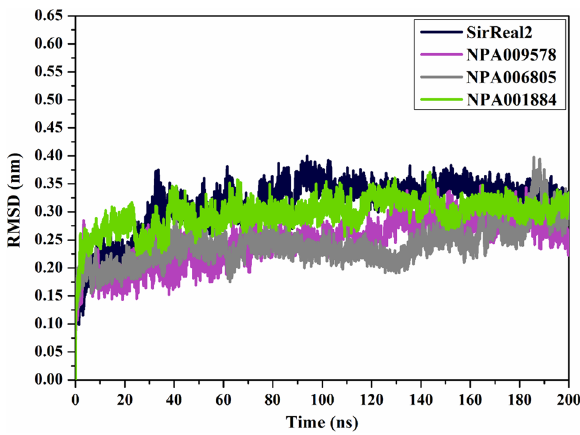
Figure 8. RMSD plot for the backbone with respect to the starting coordinates of SirReal2 (in navy), NPA009578 (in pink), NPA006805 (in gray), and NPA001884 (in green) complexed with SIRT2 protein over 200 ns MD